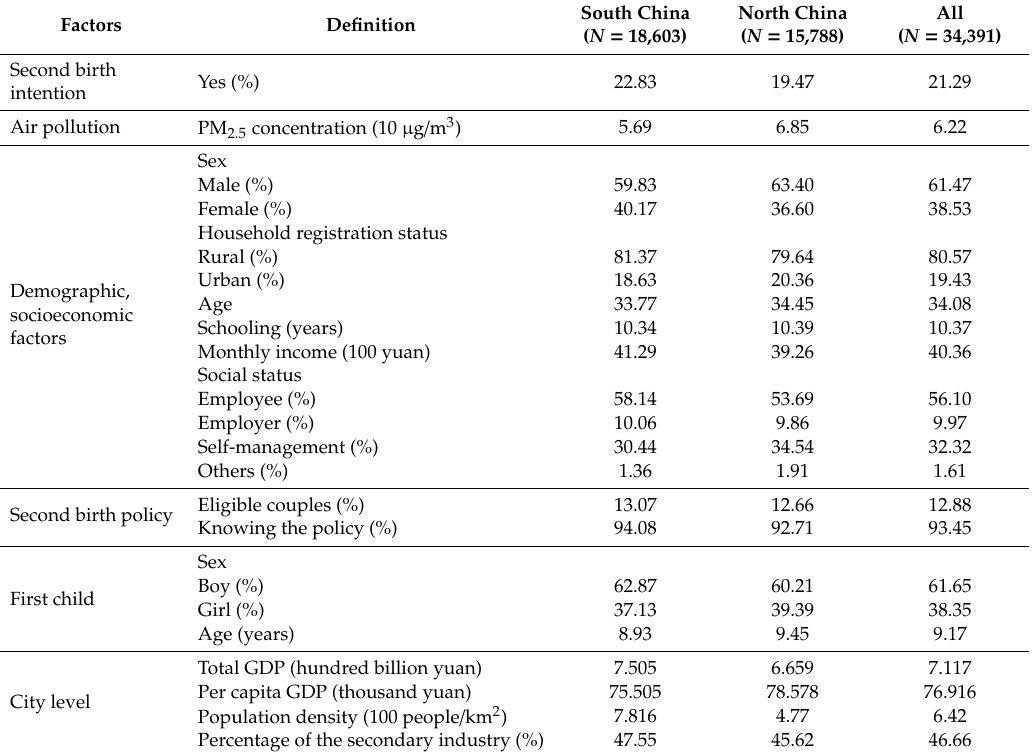
Table 1. Descriptive summary of the